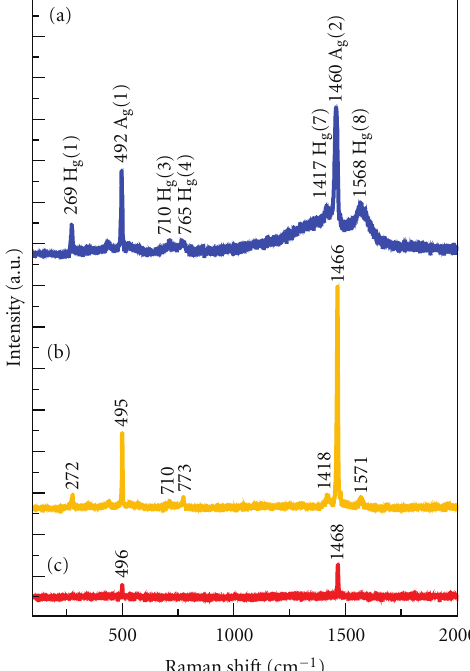
Figure 5: Raman spectra of C 60 NWs. The power density of laser beam ( D ) is (a) 11800, (b) 1660, and (c) 71.5 mW/mm 2 , respectively.